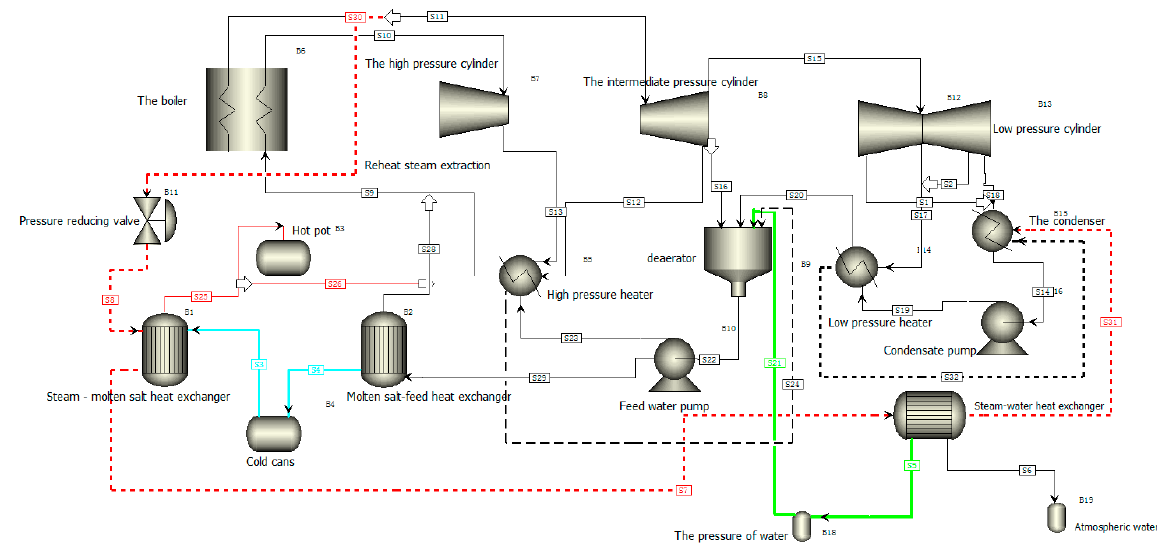
Figure 1. Thermal power plant steam heating and melting salt reservoir heat modulation system.